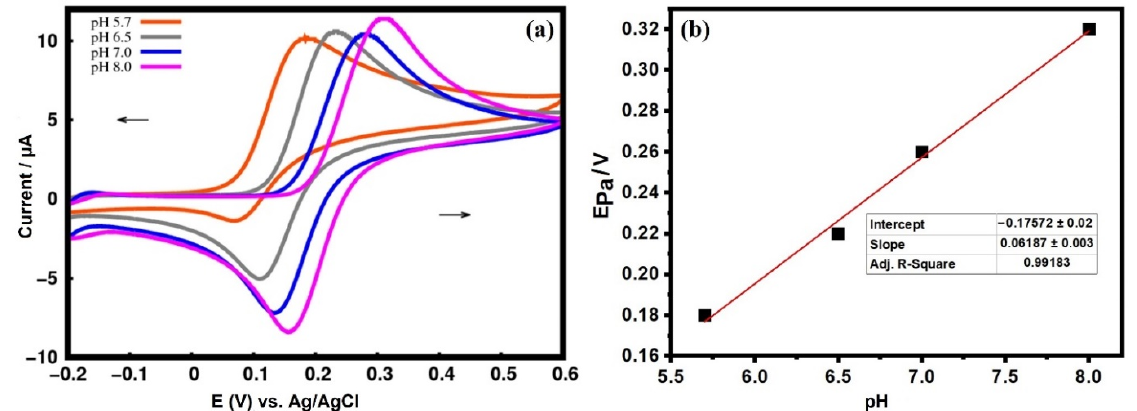
Figure 11. ( a ) The cyclic voltammogram of different pH ( b ) Plot of anodic peak potential vs. different pH.